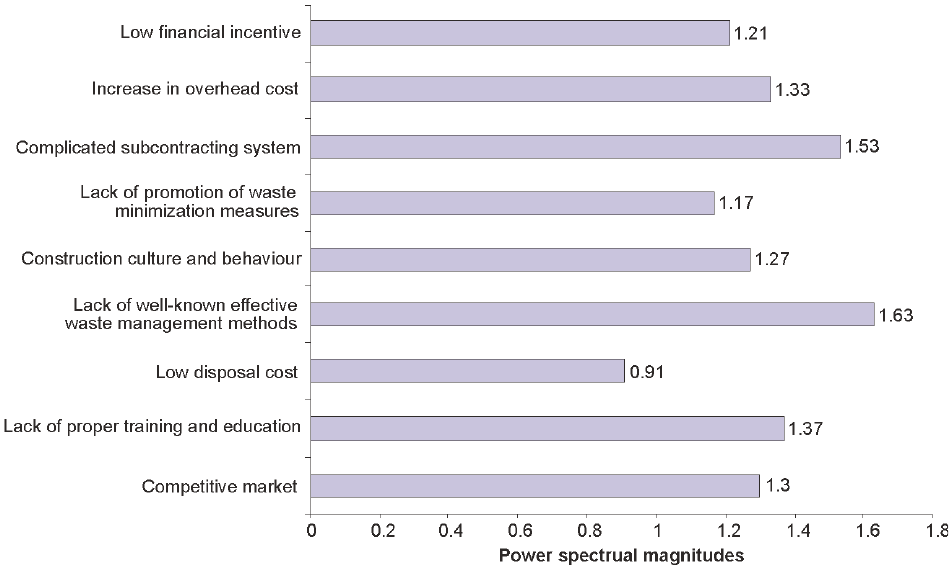
Fig. 7. Difficulties in implementing waste management systems